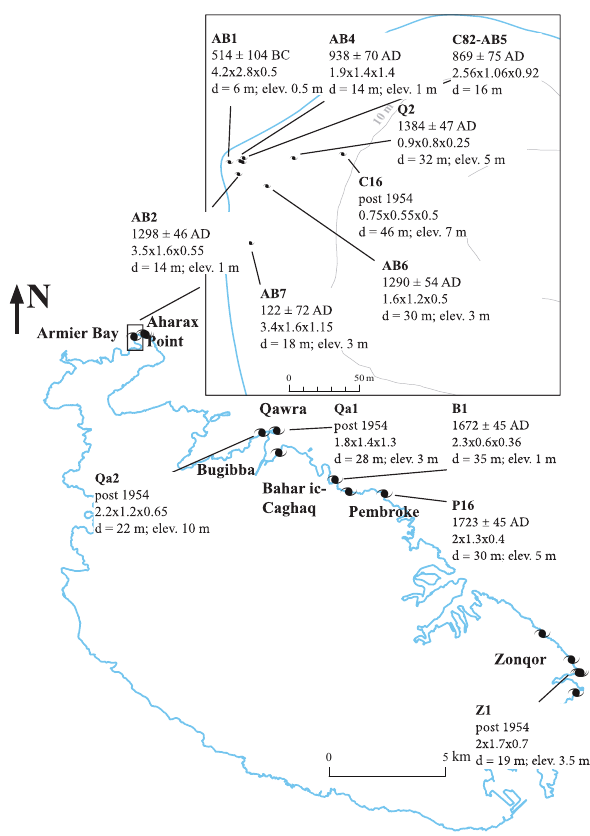
Figure 8. Location of the investigated boulders, with a zoom of the Armier Bay Ahrax Point site, with their AMS dating, size, distance from the coastline and elevation above sea